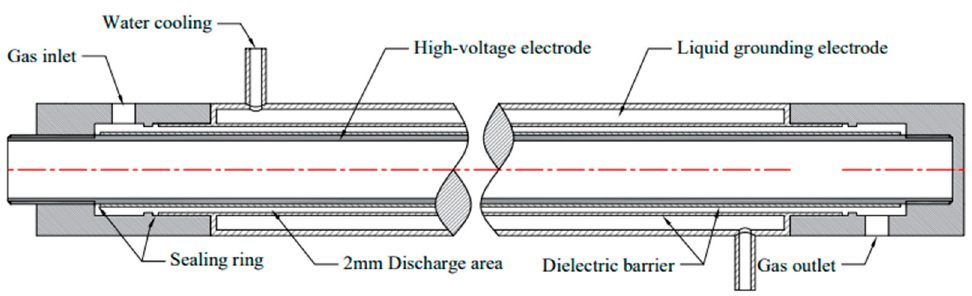
Figure 2. Structure diagram of the plasma reactor.